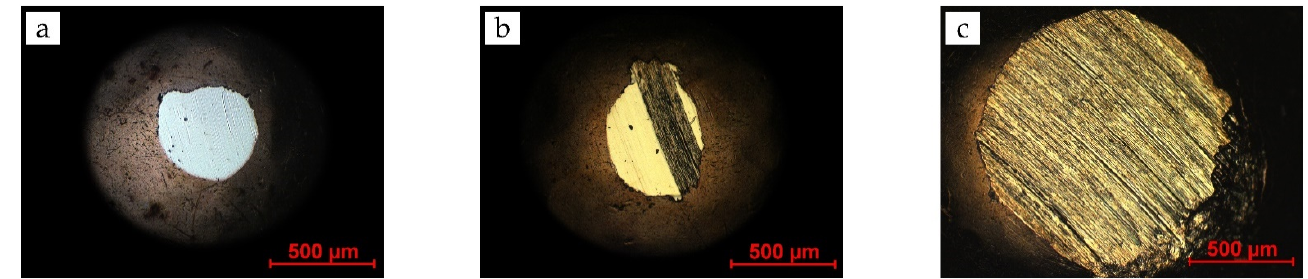
Figure 7. Light microscope images of wear scars on brass counterbodies from brass/ta-C experiments under high vacuum with a sliding length of ( a ) 12.0 m, ( b ) 54.0 m, and ( c ) 72.0 m. Two wear states are visible when comparing the left and right images. The middle image seems to consist of a hybrid between the two states.